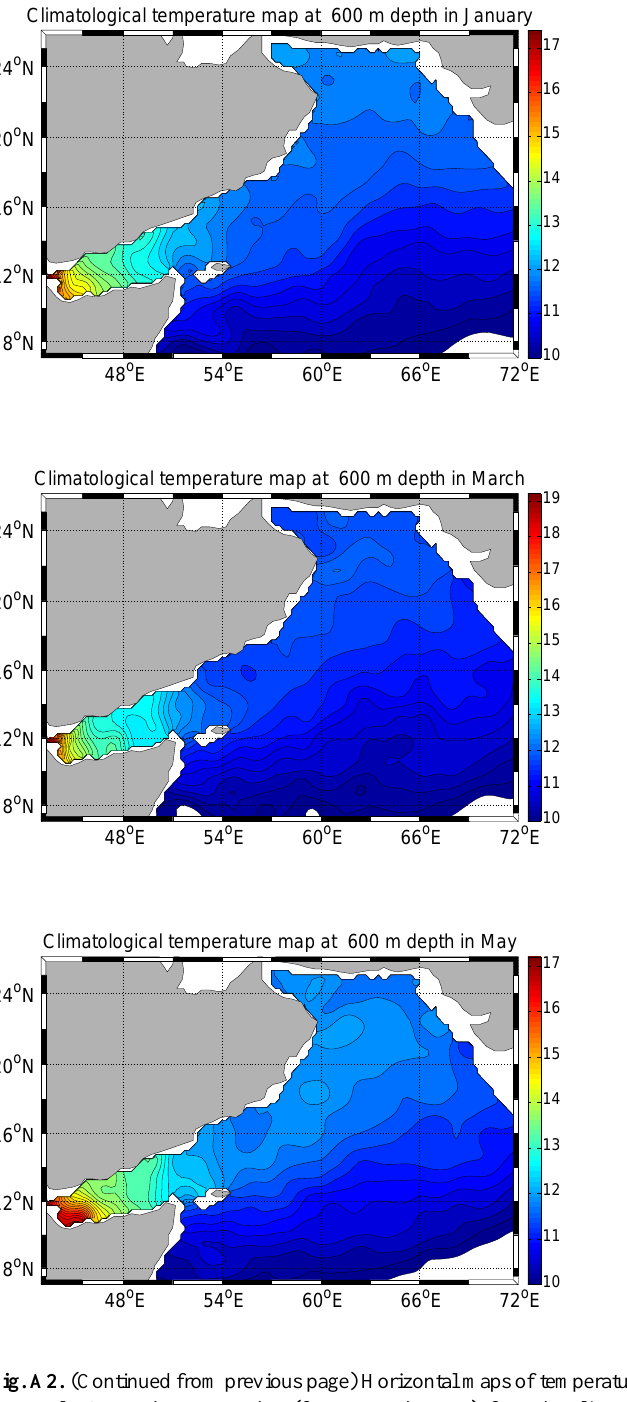
Fig. A2. (Continued from previous page) Horizontal maps of temperature (in ◦ C, left) and salinity (right) at 600m depth for January, March, May, July, September, November (from top to bottom), from the